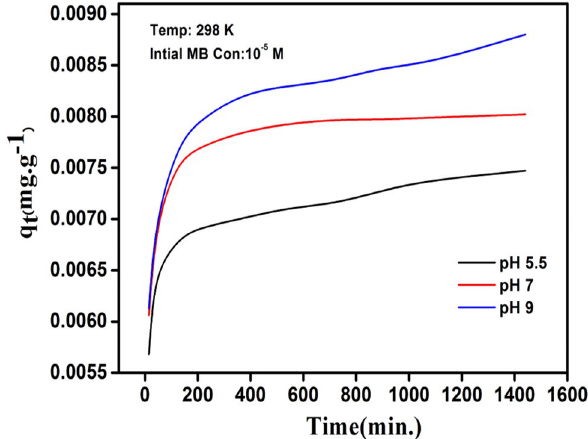
Fig. 2 The exchange of adsorption kinetics with different pH of solu-